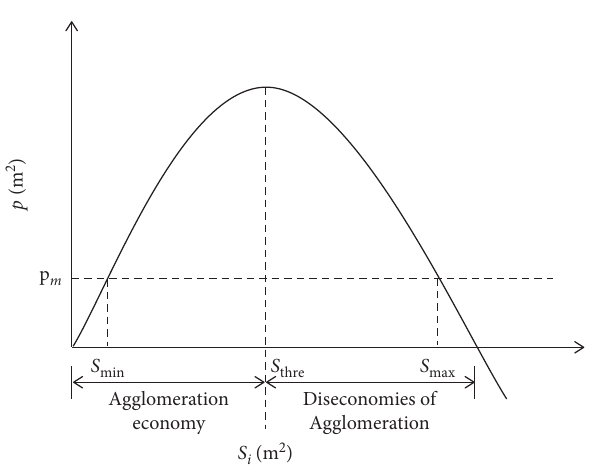
Figure 1: The relationship between p